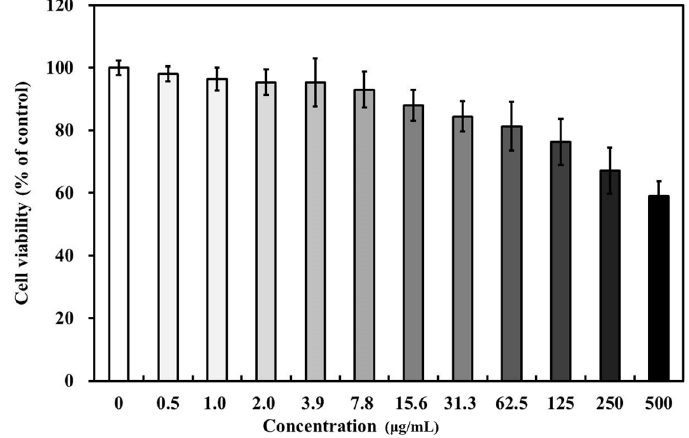
Figure 4. The viability of MC3T3-E1 osteoblasts according to increasing rGO nanoplatelet concentration ( μ g/mL).